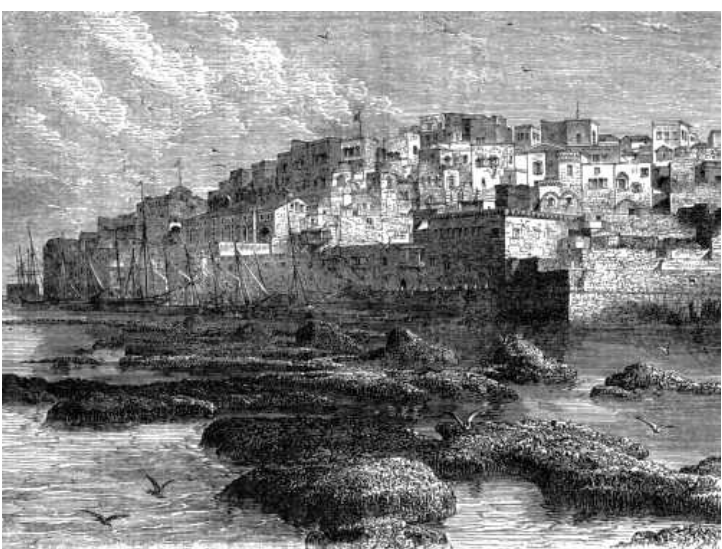
Figure 21. Abrasion platforms in the coastal water of Jaffa before they were quarried for building purposes (from [169] Seaward W. H. 1873 Travels Around the World (www.fromoldbooks.org/SewardTravels accessed on 24 August 2022).